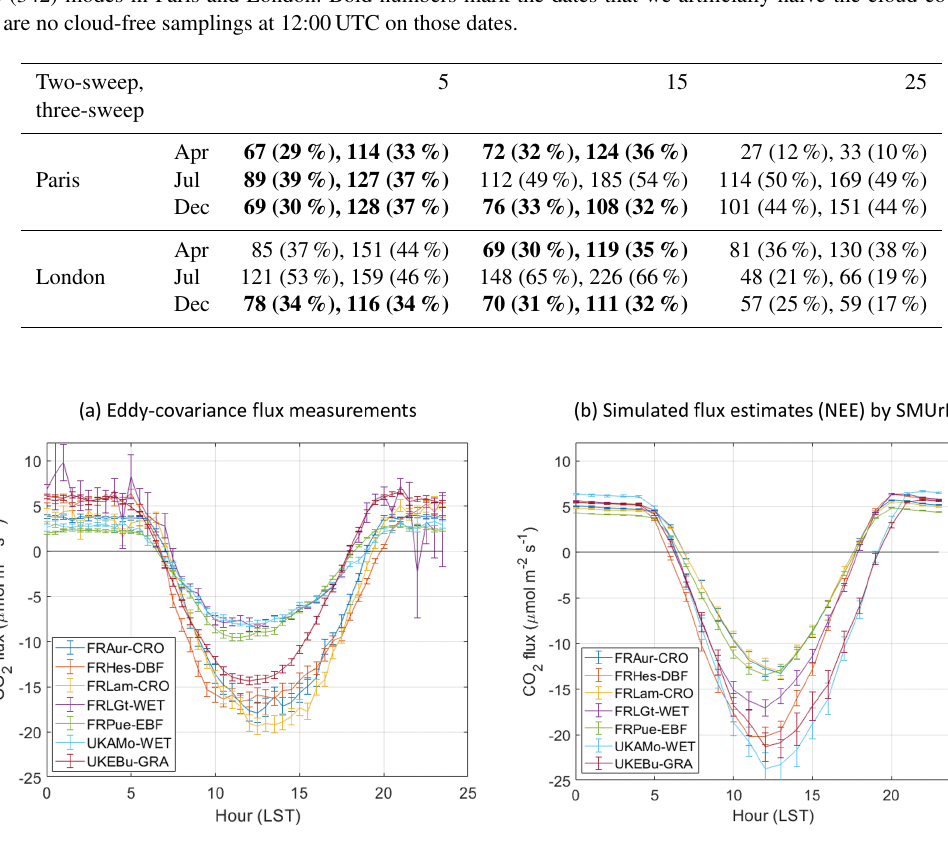
Figure A2. Diurnal variation of seasonally averaged eddy-covariance flux measurements (a) and net ecosystem exchange (NEE) simulated by the SMUrF model (b) . Error bars are the standard errors of the seasonal means. Flux data are downloaded from the European Fluxes Database Cluster, with five sites in France (FR-Aur, FR-Hes, FR-Lam, FR-LGt, and FR-Pue) and two sites in the UK (UK-AMo and UK- EBu). Site information is described on the website (http://www.europe-fluxdata.eu/home/sites-list). The land types are croplands (CRO), deciduous broadleaf forests (DBF), permanent wetlands (WET), evergreen broadleaf forests (EBF), and grasslands